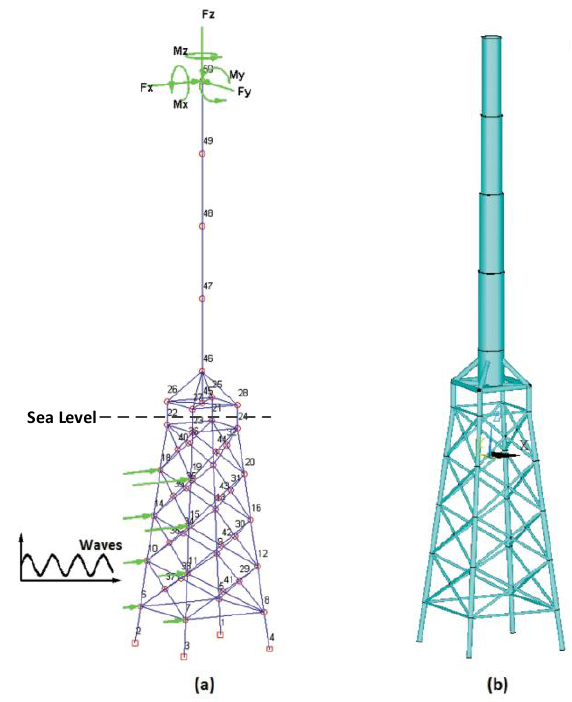
Figure 8. A sketch of a jacket support offshore wind turbine: ( a ) the MATLAB model and ( b ) the ANSYS model.